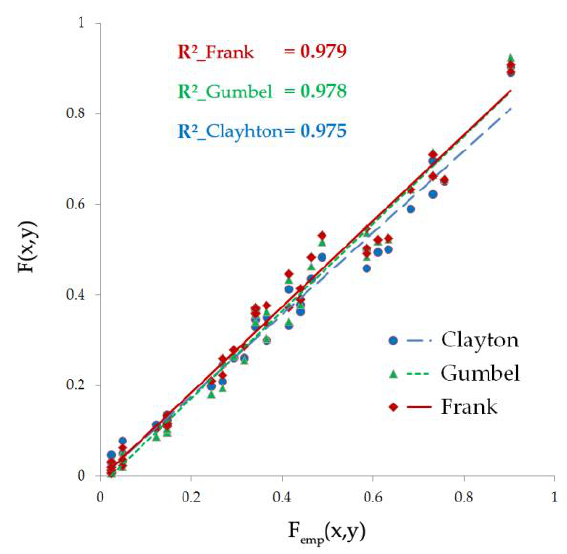
Figure 5. Empirical cumulative distribution F emp (x , y) versus theoretical cumulative distribution F(x , y) for the three types of copulas, Clayton, Frank, and Gumbel.